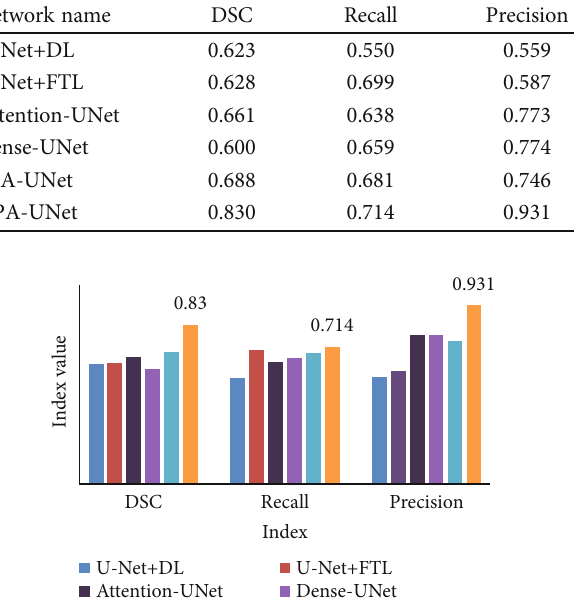
Figure 3: Comparison of U-Net and its improved network evaluation indicators.